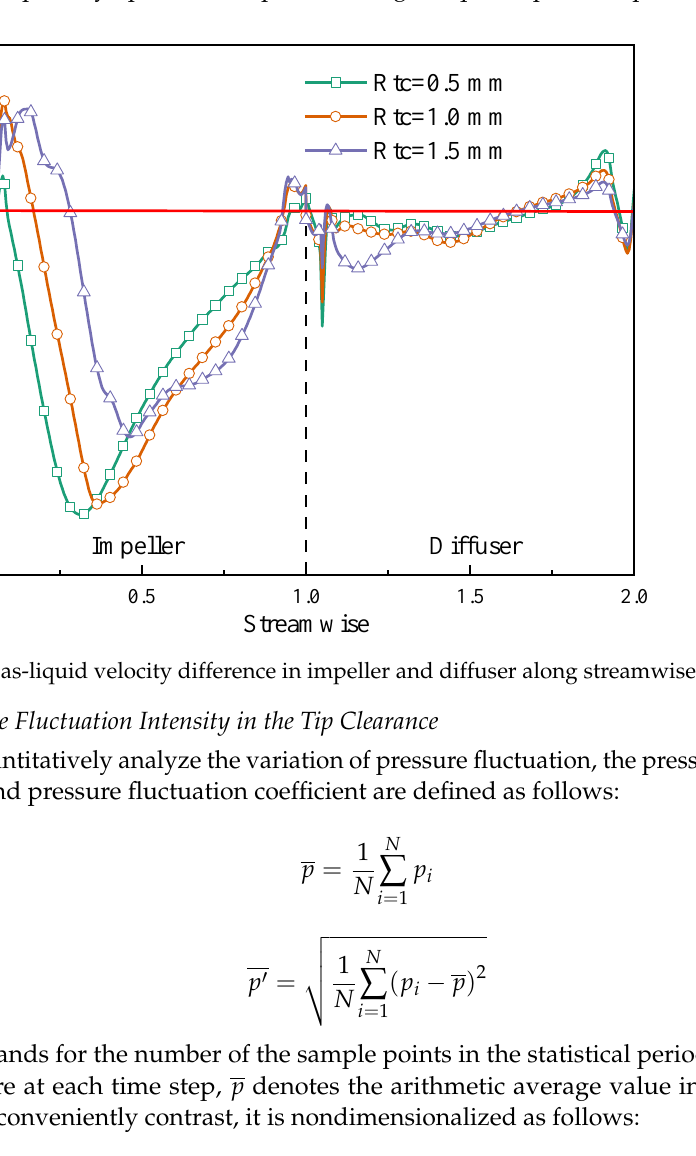
Figure 14. Gas streamlines near impeller blade tip.